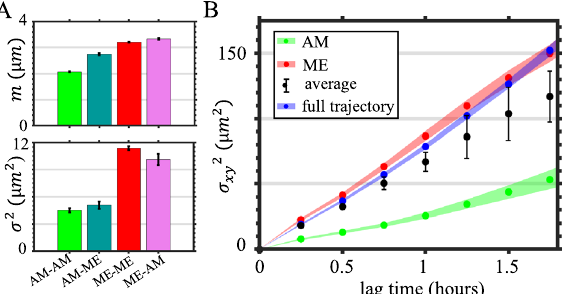
Figure 5. Cancer cell migration in 3D ECM is coupled with morphological phenotype and phenotype transitions. ( A ) Means ( m , upper panel) and variances ( σ 2 , lower panel) of the step size distributions by fitting the experimental measurements with log-normal distribution. The steps are categorized based on morphological phenotype (coarse-grained as mesenchymal, amoeboidal and intermediate state) dynamics. ME: abbreviation for mesenchymal, which includes FP and LA states. AM: abbreviation for amoeboidal, which includes BB and AE states. If a cell makes a step by starting from AM state to ME state, the step is categorized as an AM-ME step. The starting and ending frames of steps are separated by 15 minutes. In ( A ) errorbars show the 95% confidence interval of fitted parameters. ( B ) Real-space (2D projection) mean square displacements (MSD) of cells. AM: the MSD of cells dwelling in the AM state. ME: the MSD of cells dwelling in the ME state. average: the weighted average of mean square displacements of AM, ME, and intermediate dwelling cells. The average is based on the occurrence fraction of AM, ME and intermediate state of cells. Full trajectory: the MSD obtained from entire cell trajectories regardless of the morphological phenotypes. Shaded areas in C show SEM. In (A-B) a total of 1974 hours of single cell trajectories are analyzed. The ECM are prepared at room-temperature with a concentration [col] = 1.5 mg/mL. This figure is prepared with Matlab R2020a (www. mathw orks. com) and ImageJ (https:// imagej.